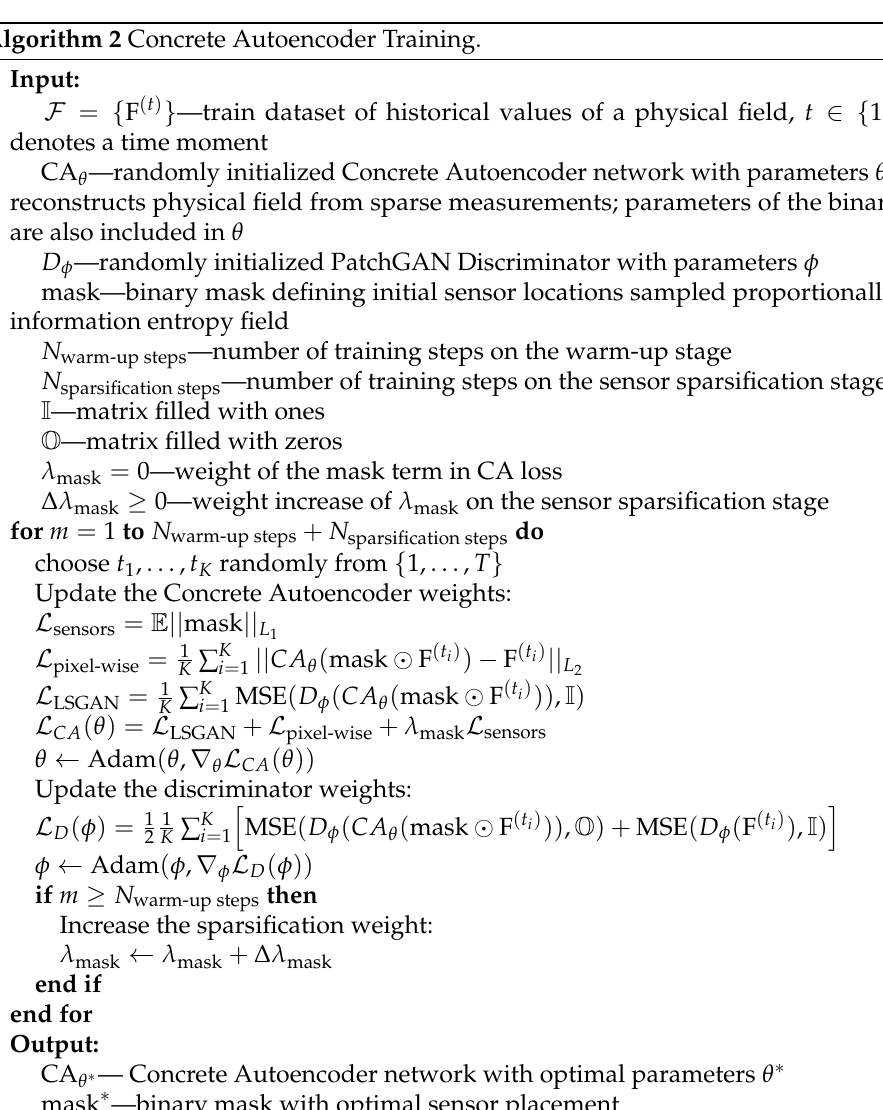
Algorithm 2 Concrete Autoencoder